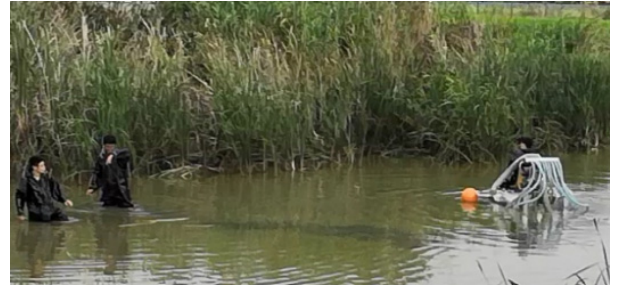
Figure 7. Driving test site.